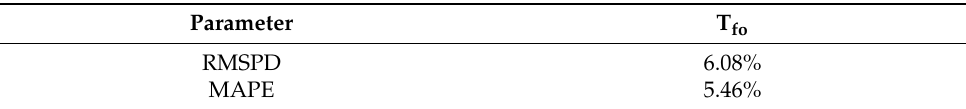
Figure 6. The Variation in the temperature output against the change in the mass flow rate: a comparison between the study of El-Sebaii et al. [45] and our simulation. Table 4. The accuracy analysis of the theoretical model.